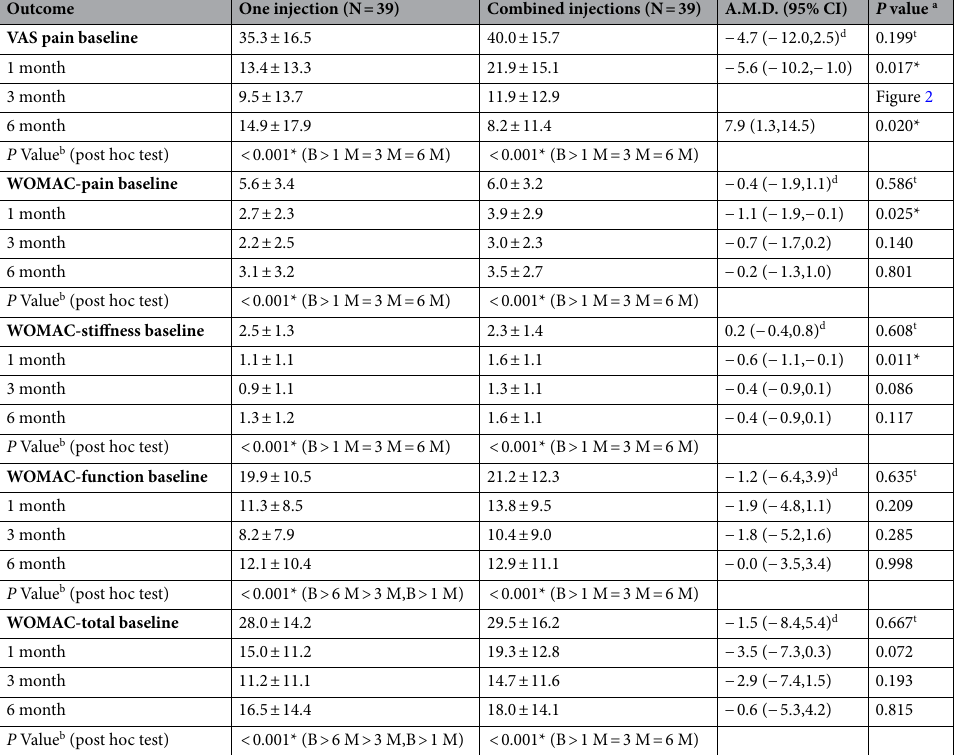
Table 3. Comparisons of outcomes among groups at different time points and across four waves of times in individual groups. The values are given as mean ± standard deviation. VAS Visual analog scale for pain, WOMAC The Western Ontario and McMaster Universities Osteoarthritis Index, A.M.D. Adjusted mean difference, CI Confidence interval. a Between-group difference determined using independent samples one- way ANCOVA(baseline data as covariate) or Johnson-Neyman technique (Fig. 1). b Within-group difference determined using repeated measures one-way ANOVA. t independent t-test. * P <